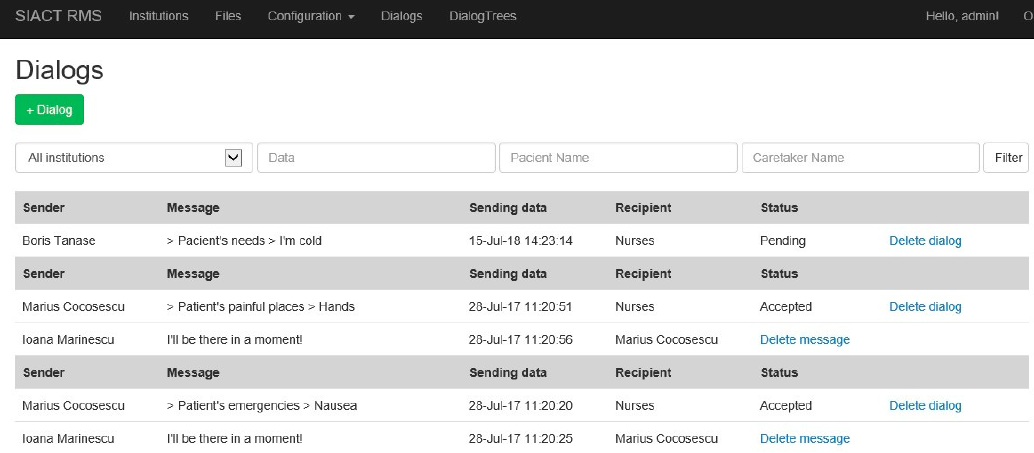
Figure 18. Dialogues between patients and caretakers recorded in the Server database.